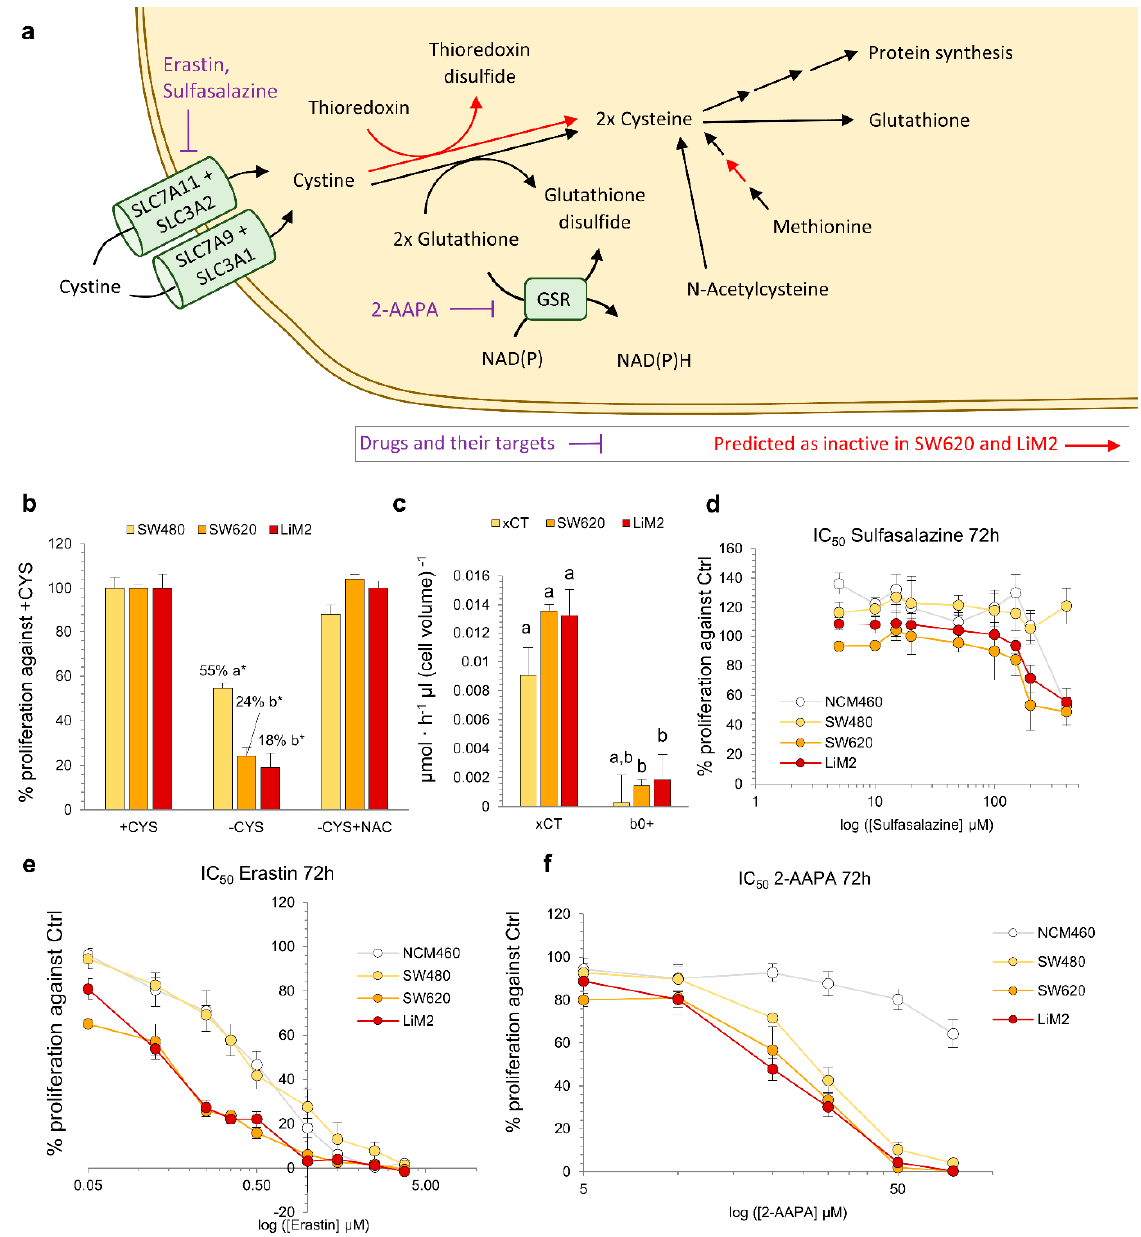
Figure 5. Metastatic cells are dependent on cystine uptake and vulnerable to system xCT and glutathione reductase inhibition. ( a ) Representation of cystine and glutathione metabolism. ( b ) Cell proliferation measured by DNA content using HO33342 under cystine deprivation (-CYS) and adding N-acetylcysteine (-CYS+NAC). *Student’s t test for –CYS or –CYS+NAC vs. Control conditions, p < 0.05. a,b A one-way ANOVA and Scheffe’s test for multiple comparisons for the factor “cell line”. ( c ) Predicted fluxes through the system xCT and b 0,+ system, a,b,c denote cell lines and reactions with an overlap of the sampled flux values for a given reaction. ( d ) and ( e ) Cell viability curve for ( d ) sulfasalazine (system xCT inhibitor), ( e ) erastin (system xCT inhibitor) and ( f ) 2-AAPA (GSR inhibitor) assessed by DNA content after 72 h incubation. Statistical analyses of the IC 50 curves are shown in Table S3.